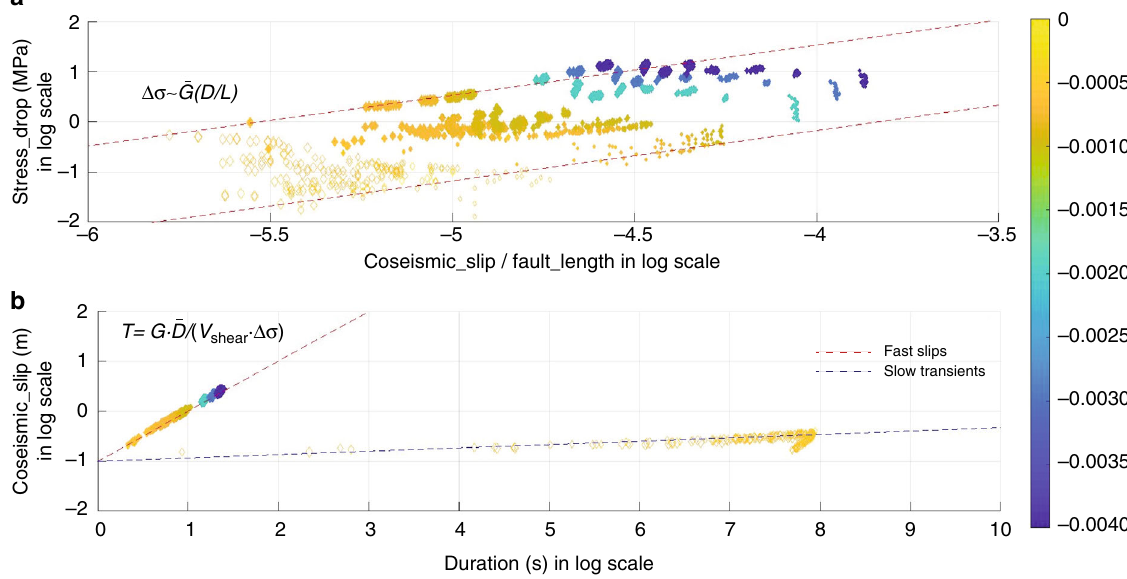
Fig. 4 Seismic scaling relationships. a Relationship between strain change and stress drop. For fast and slow transient events strain drop generally scale linearly (dashed lines) with stress drop. Observations show that stress drop is independent of fault size. Within the linear dependence our results agree with observations. b Scaling relationship between co-seismic slip and duration. Duration of simulated earthquakes scales linearly with co-seismic slip. However, slow transient departs widely from this scaling. Filled diamonds: earthquake events. Un fi lled diamonds: slow transients. The size of the diamonds represents the length of the modeled fault, L and the color scale shows the value of a − b , from 0 (yellow) to − 0.004